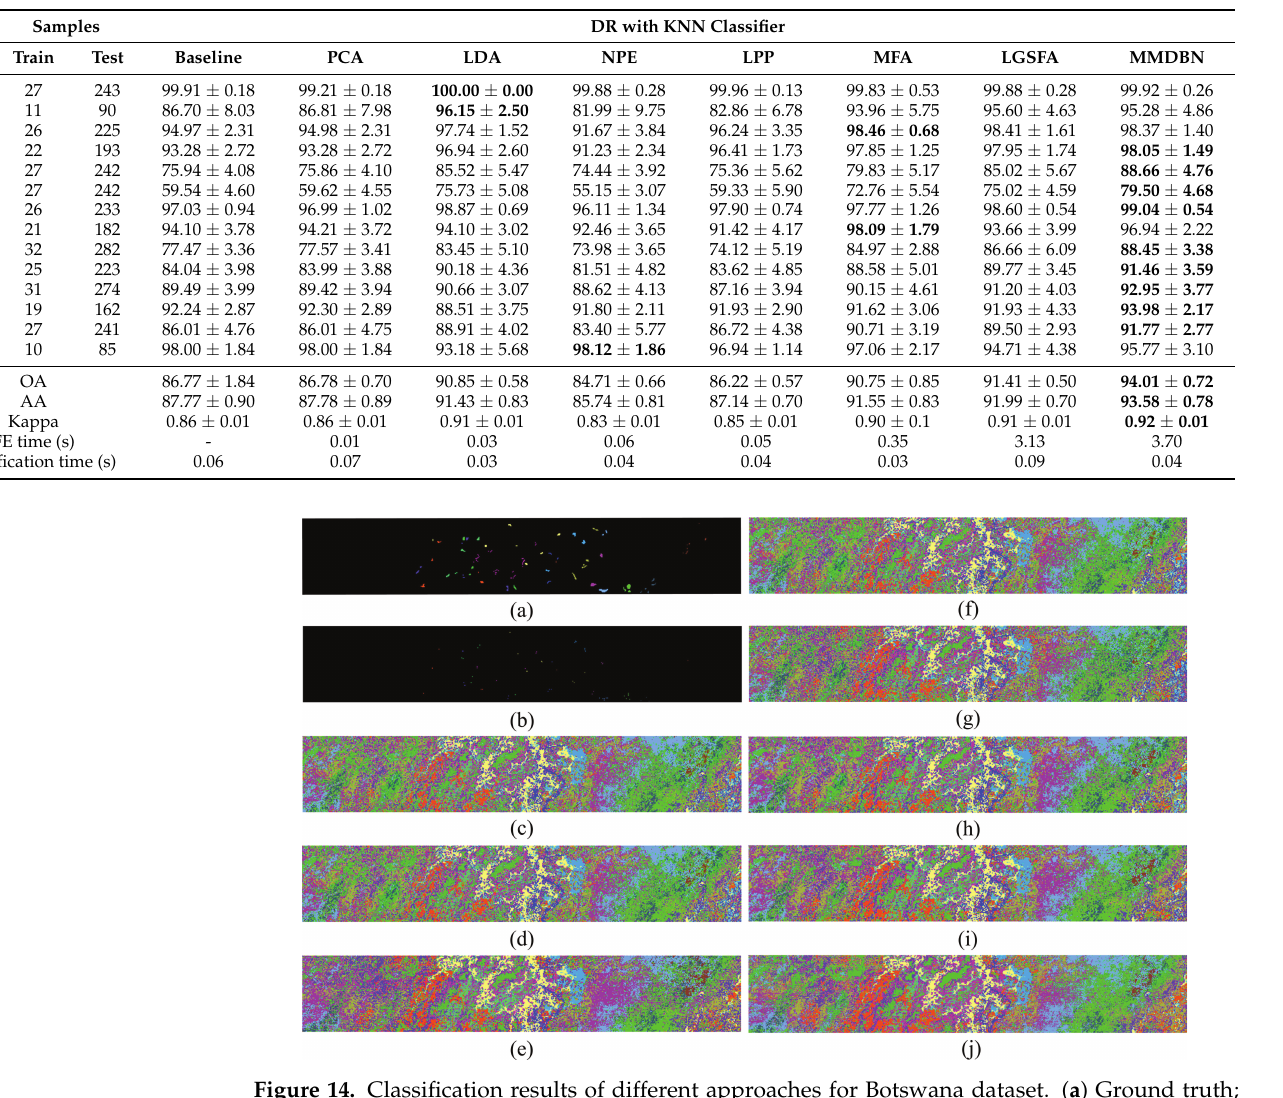
Figure 14. Classification results of different approaches for Botswana dataset. ( a ) Ground truth; ( b ) Training samples; ( c ) Baseline; ( d ) PCA; ( e ) LDA; ( f ) NPE; ( g ) LPP; ( h ) MFA; ( i )